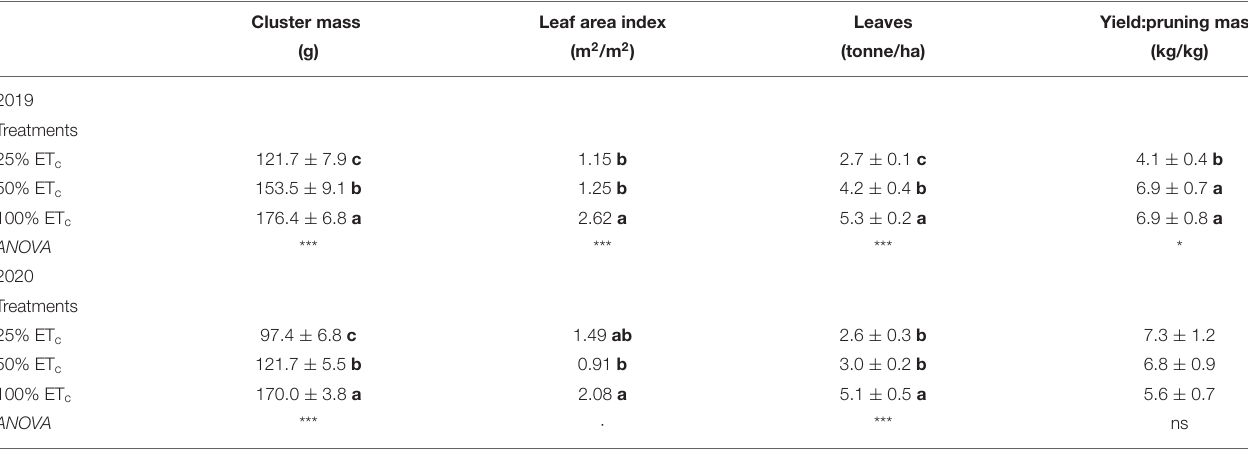
TABLE 1 | Reproductive and vegetative growth of Cabernet Sauvignon grapevines (clone FPS08) subjected to different replacement of crop evapotranspiration (25, 50, and 100% ET c ), collected in Oakville, CA, in 2018–2019 and 2019–2020